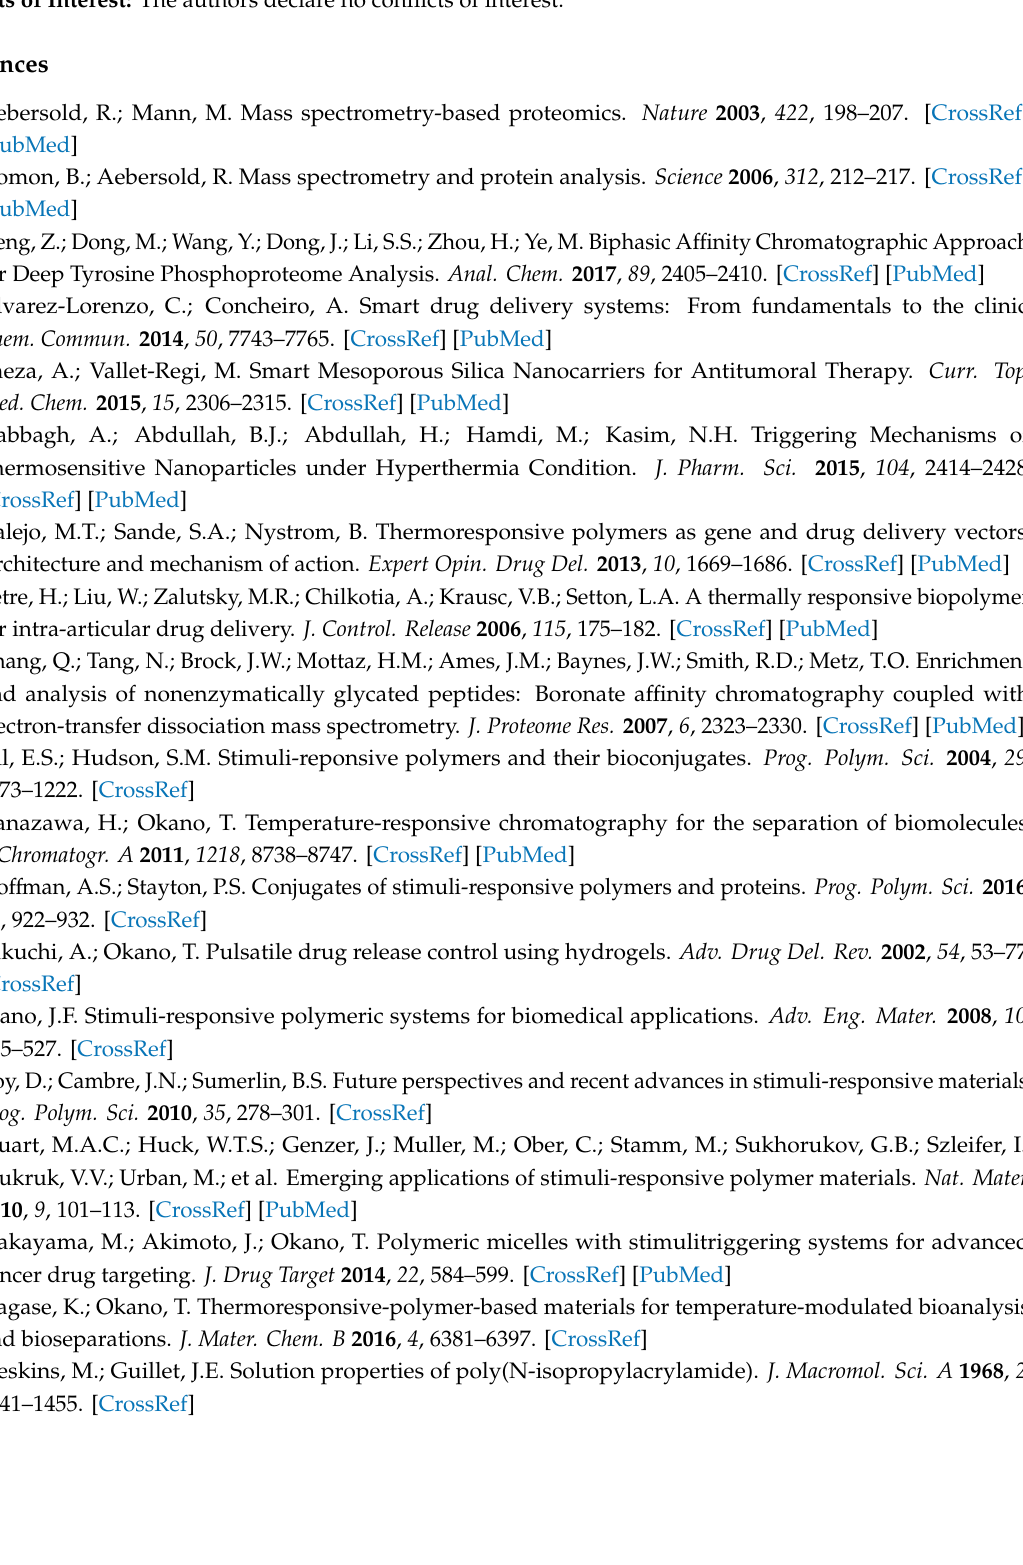
Table S3. Type of proteins in group 1. Table S4. Type of proteins in Group 3. Table S5. Type of proteins in Group 5. Table S6. Type of proteins in Group